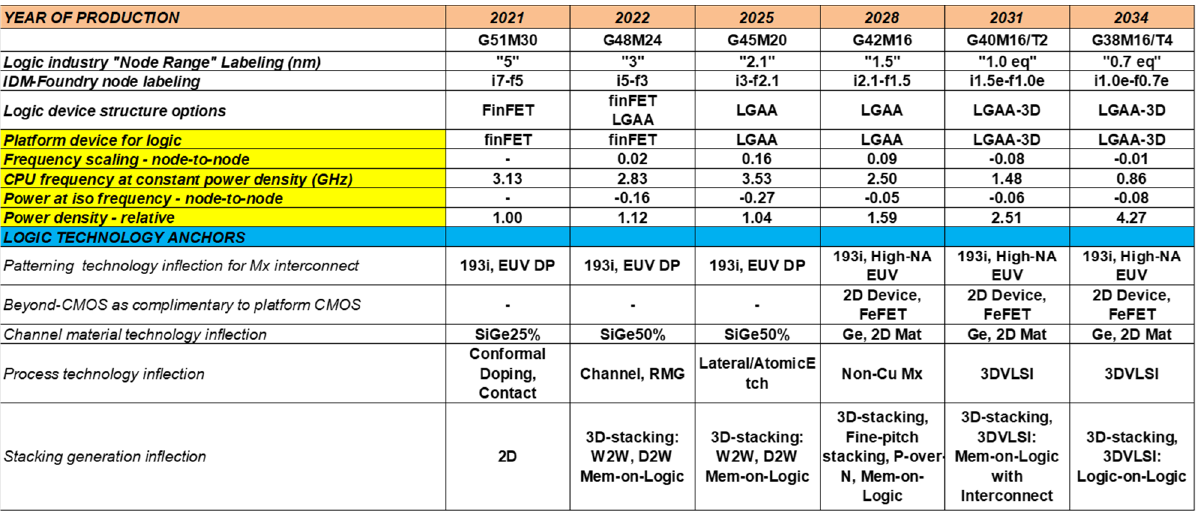
Figure 10. Technology node adopted by IRDS.